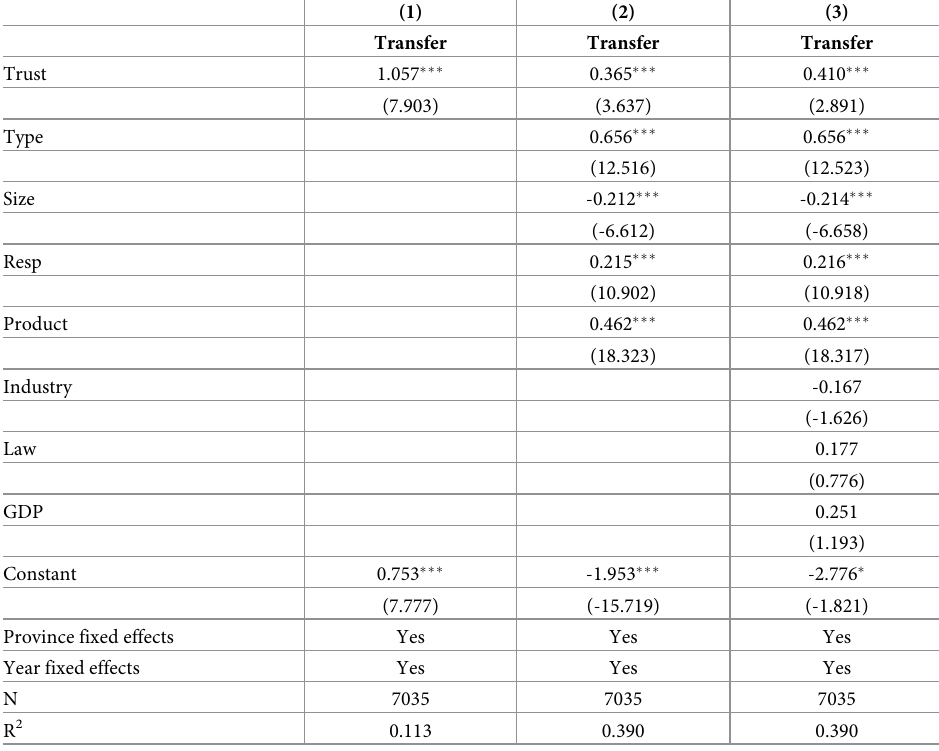
Table 3. The impact of social trust on university technology